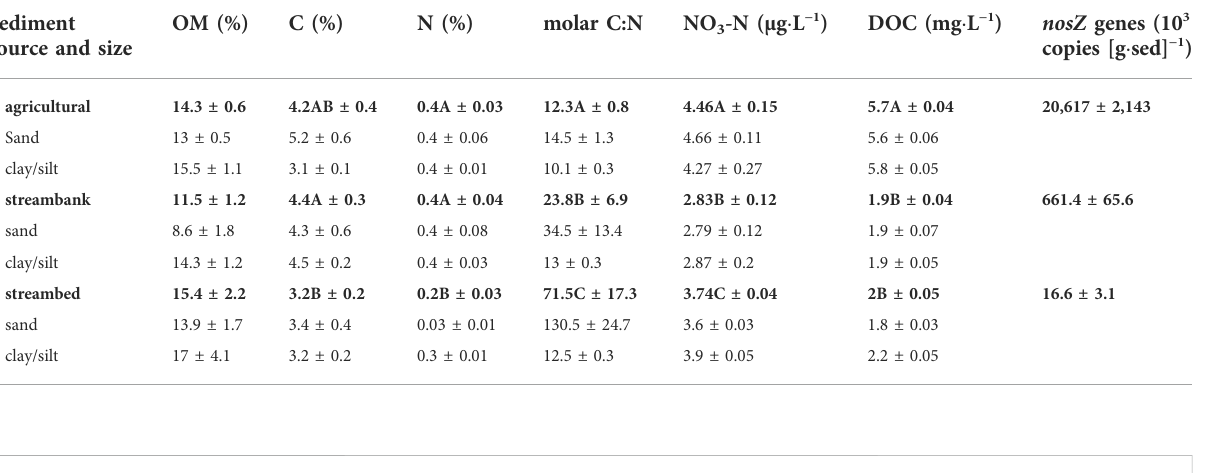
TABLE1Biogeochemicalproperties ofsedimentsourcesandsizefractions,includingorganicmattercontent(OM),CcontentinOM(C),Ncontentin OM (N), molar C-to-N ratio (molar C:N), concentration of nitrogen-nitrate (NO 3 -N), concentration of dissolved organic C (DOC), and number of denitrifying nosZ genes per sediment mass (nosZ genes). Values in bold show the means +/ − SEM based on all replicates for each sediment type ( N = 12), except for nosZ genes. Means +/ − SEM for associated size fractions ( N = 6) within each sediment type arelisted below bolded value. Mean values within a column with unique superscripts are signi fi cantly different ( p < 0.05) following Kruskal – Wallis and unpaired Wilcoxon